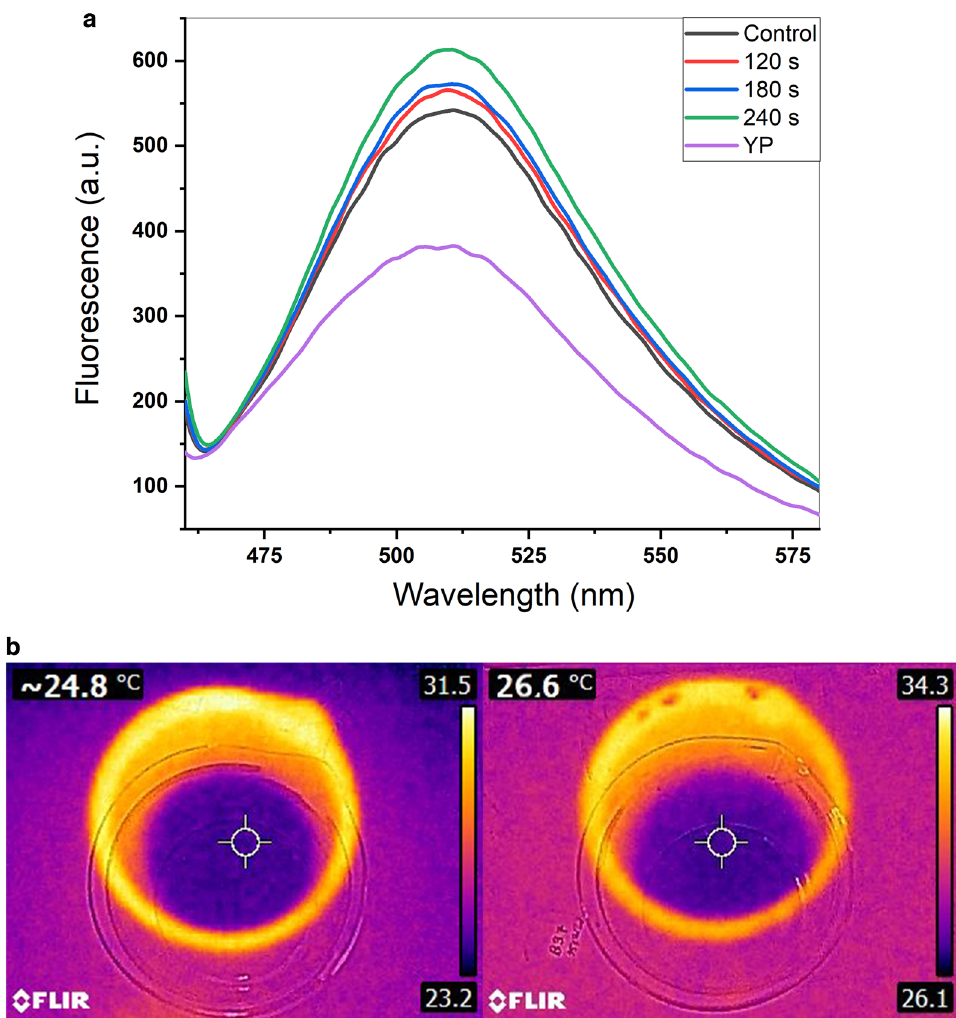
Figure 4. ( a ) The results of CAP treatment over various time periods on measured eGFP fluorescence activity. ( b ) Heat profile before (left) and after (right) 240 s CAP